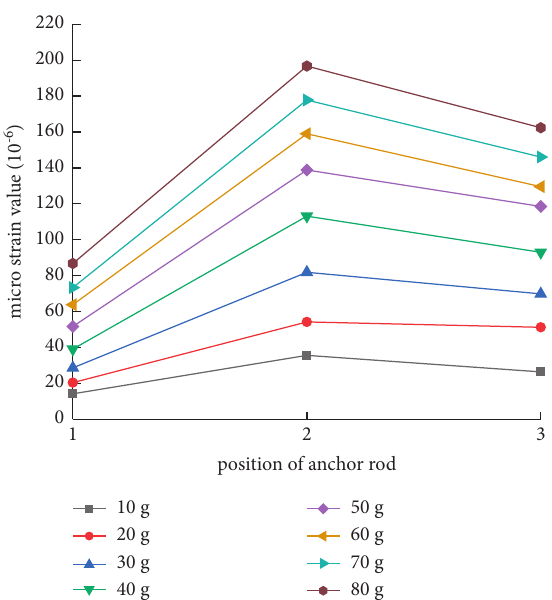
Figure 14: Comparison of axial strain at the end of different tested anchor